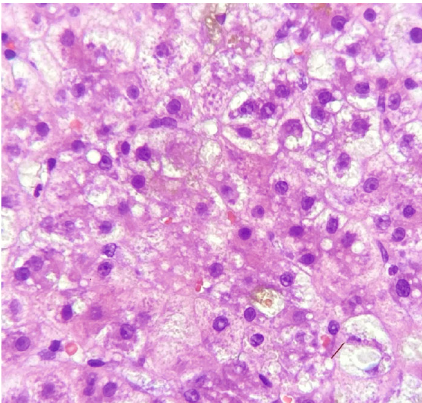
Figure 1: Microvesicular steatosis. Note the small white intracytoplasmic vesicles in the hepatocytes (400x, H&E staining). Source: own